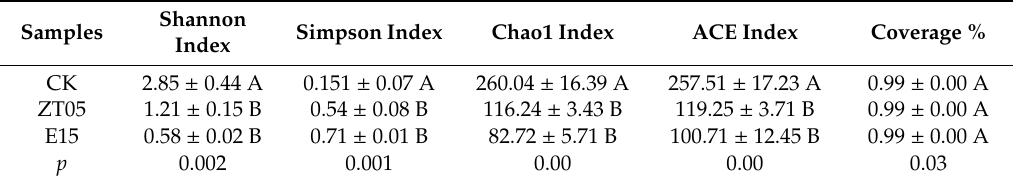
Table 3. E ff ects of Trichoderma inoculation on diversity indices of the soil fungal community in the CK, ZT05, E15. CK: inoculation with PD blank culture medium; ZT05: single inoculation with T. virens ZT05; E15: single inoculation with T. harzianum E15. Di ff erent letters in the columns indicate significant di ff erences ( p < 0.05), according to Duncan’s new multiple range test.